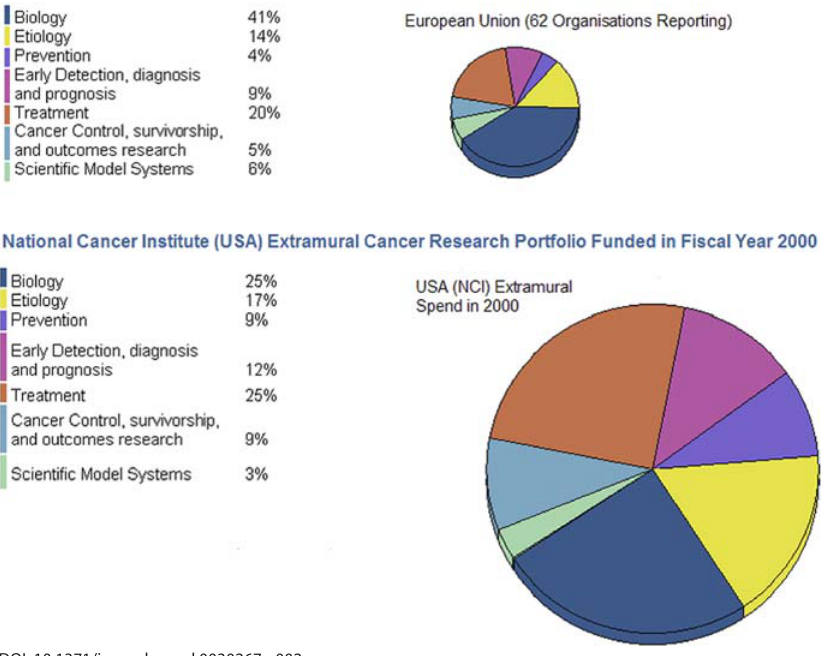
DOI: 10.1371/journal.pmed.0030267.g002 Figure 2. Percentage Spending by CSO: EU versus US The relative sizes of the two pie charts are proportional to the sizes of the two budgets.